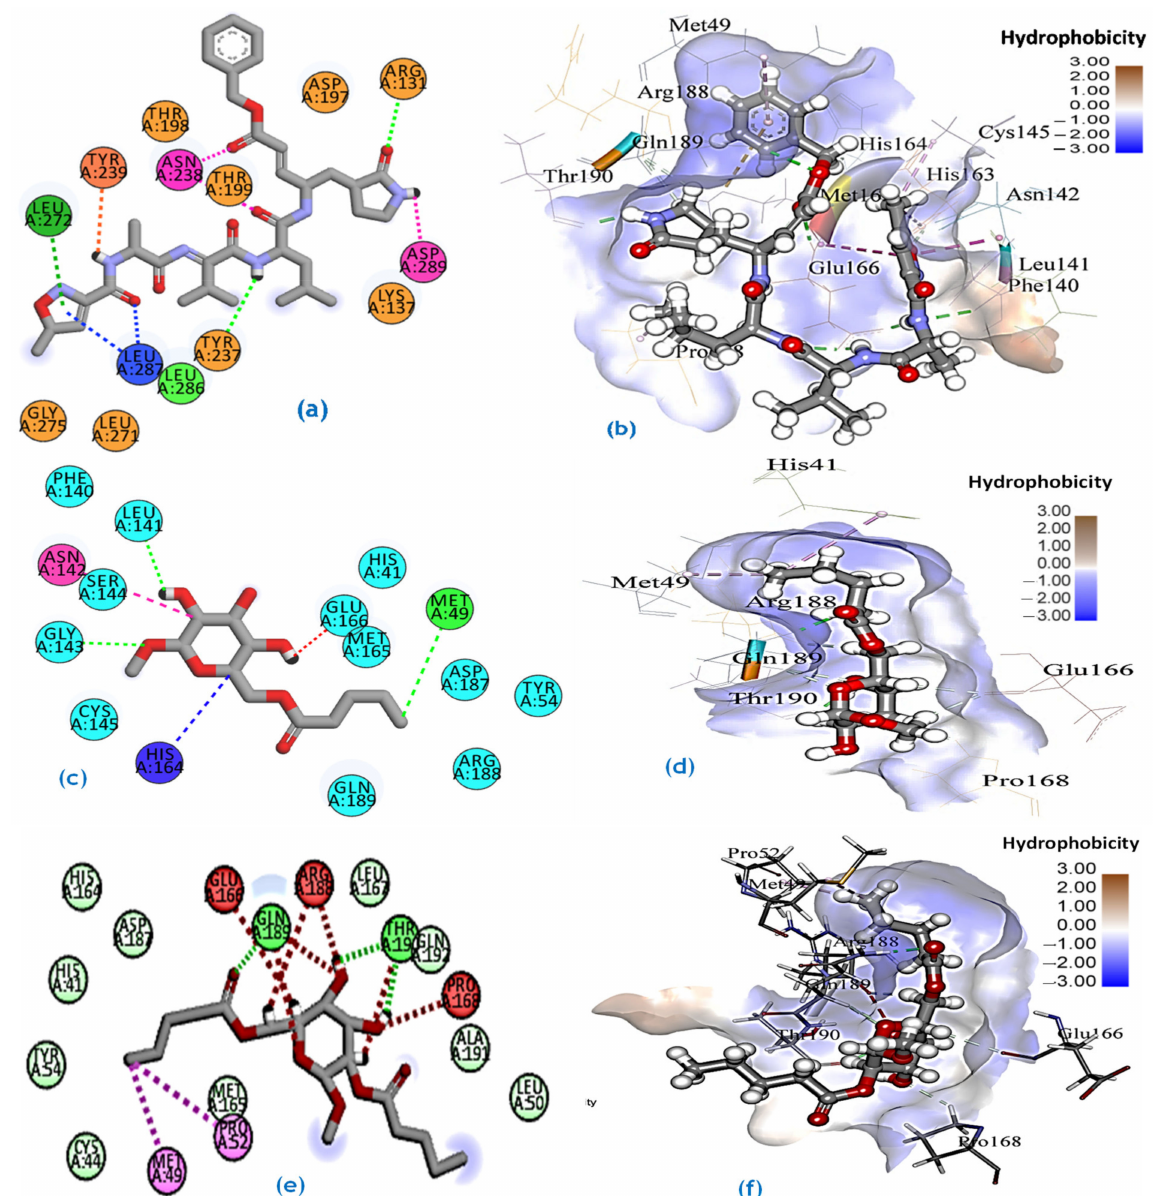
Figure 6. Binding modes of compounds with SARS-CoV-2 main protease 6LU7. ( a , b ) Inhibitor N3 and 6LU7 complex; ( c , d ) compound 4 and 6LU7 complex; ( e , f ) compound 5 and 6LU7 complex. Molecular interactions are displayed in hydrophobic surface view. The hydrophobic intensities of the binding site ranged from − 3.00 (least hydrophobic area—shaded blue) to 3.00 (highly hydrophobic area—shaded